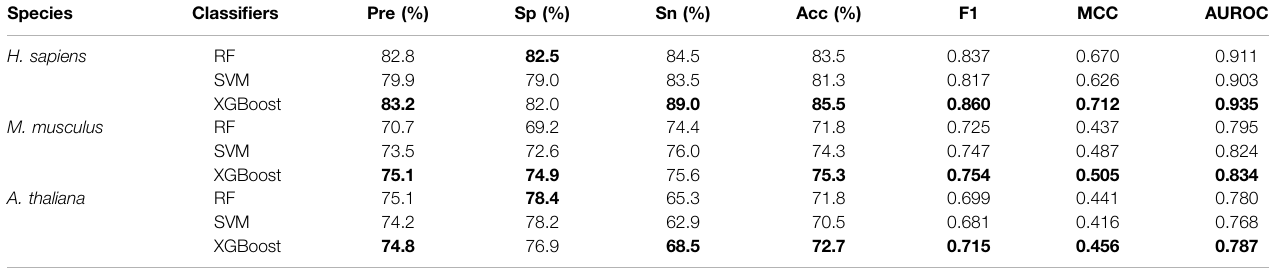
TABLE 4 | The fi ve-fold cross-validation results for models based on features selected by SHAP or the original 808 features. Species Feature used Pre (%) Sp (%) Sn (%) MCC AUROC H.sapiens Features selected by SHAP Features selected by SHAP Features selected by SHAP